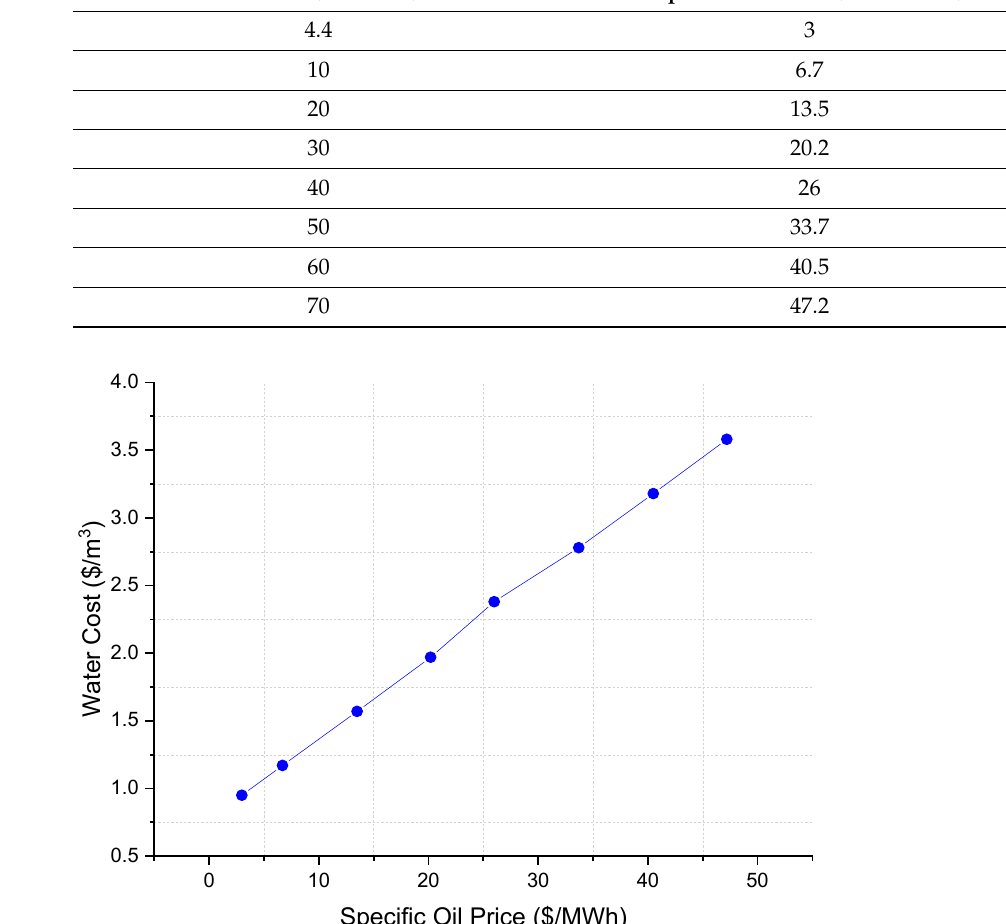
Figure 8. Sensitivity analysis of water cost (USD/m 3 ) versus specific oil price (USD/MWh) for oil-fired steam boilers. Table 10. Specific oil prices (USD/MWh) for selected oil prices (USD/bbl).